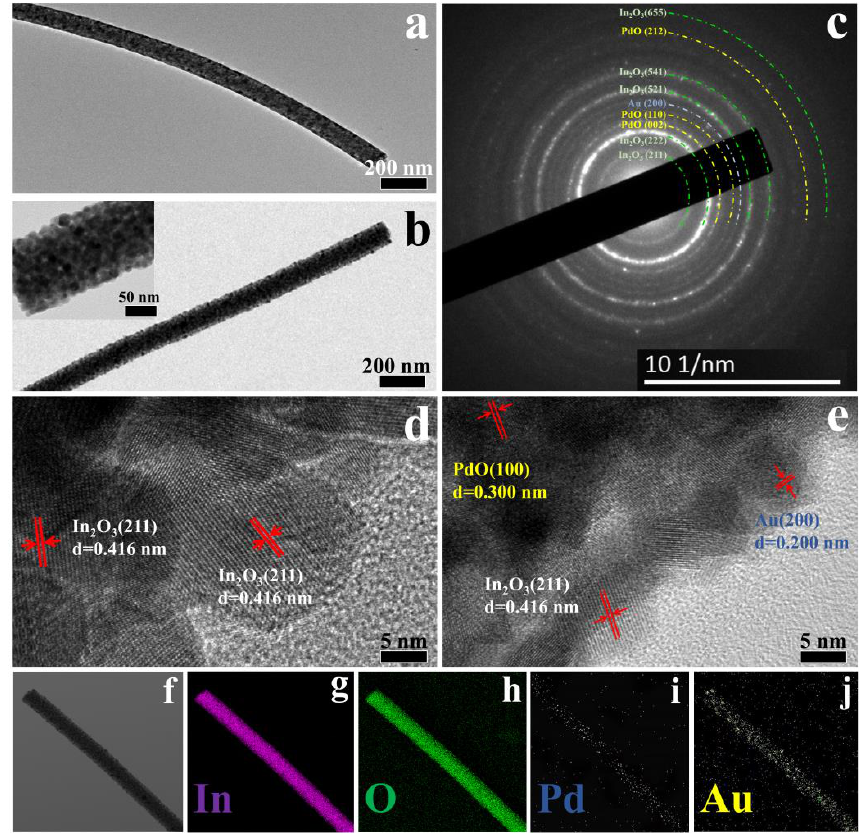
Figure 4. ( a , b ) TEM of pure In 2 O 3 and Au2Pd2-In 2 O 3 ; ( c ) SAED pattern of Au2Pd2-In 2 O 3 ; ( d , e ) HRTEM of pure In 2 O 3 and Au2Pd2-In 2 O 3 ; ( f – j ) elemental mapping images of Au2Pd2-In 2 O 3 . XPS is carried out to analyze the surface chemical compositions as shown in Figure